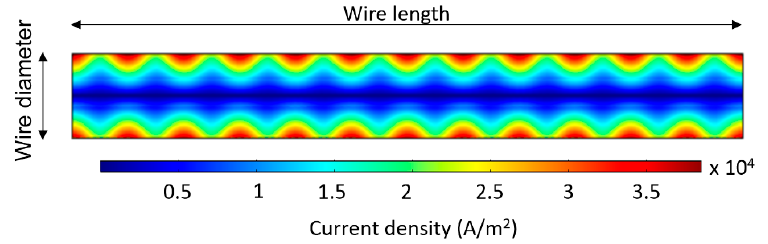
Figure 8. Current density distribution along a longitudinal cross ‐ section of an armor wire in Cable 1 (dimensions not to scale).